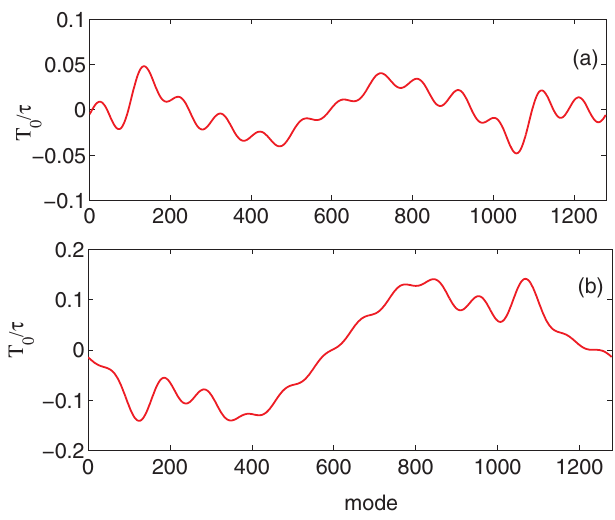
FIG. 8. (Color) Growth rate of horizontal coupled-bunch insta- bility estimated by the wake force in Fig. 6. Plots (a) and (b) depict the growth rates for two secondary rates of (cid:3) and 1.5, respectively. Primary electrons are produced at a photon-illuminated position, and 30% of them are produced uniformly on the chamber